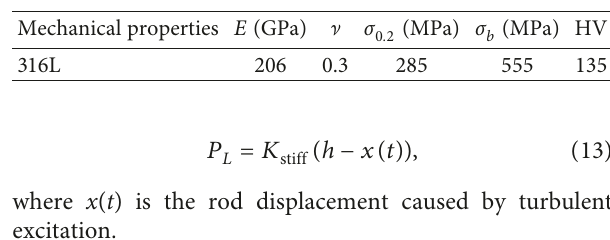
Table 2: Main mechanical properties of 316L